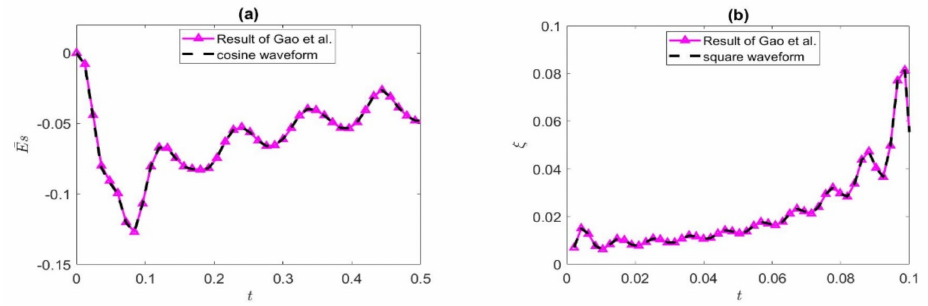
Figure 2. The present results are compared with the streaming potential ( a ) and EKEC efficiency ( b ) of Gao et al. [55] in ( a ) De = 1, ϕ = 2%, ω = 60, Ha = 2, K = 2; ( b ) De = 1, ϕ = 2%, ω = 2, Ha = 1, K =